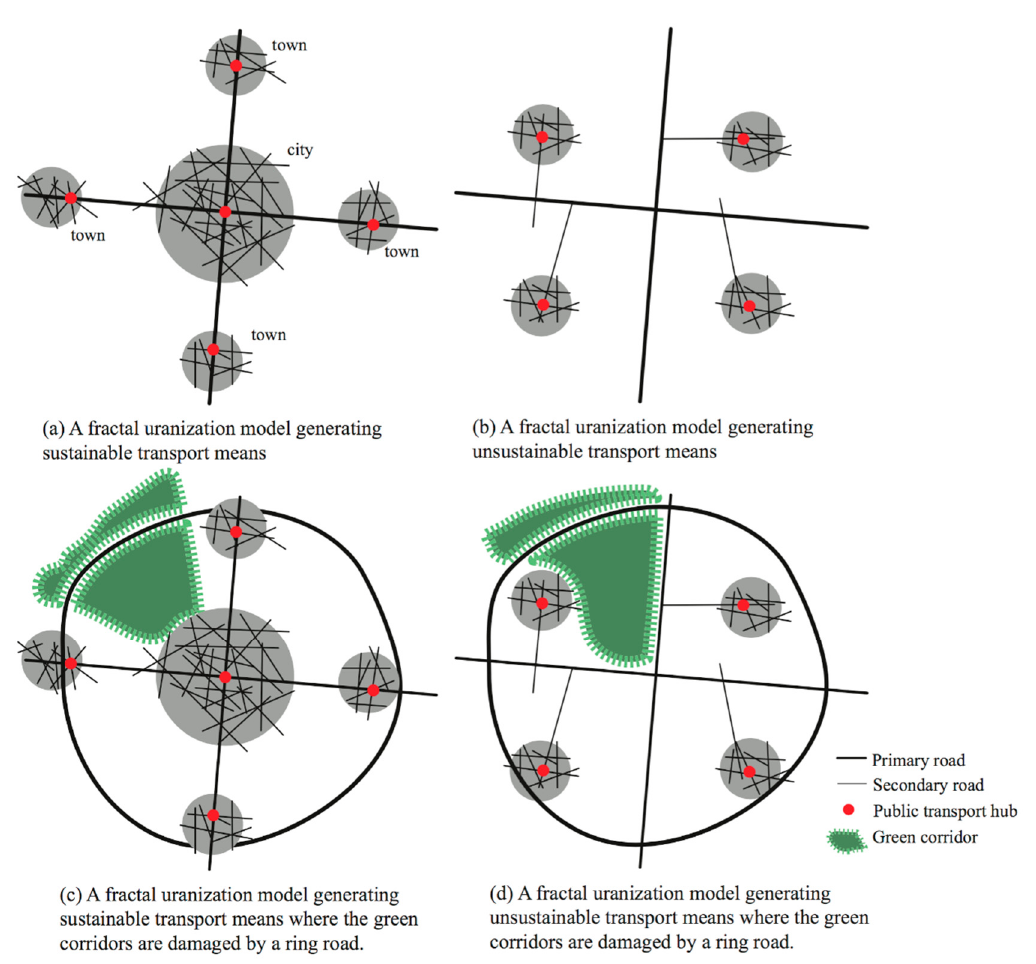
Figure 8. Schemes showing some spatial fractural principles in the relationship between the local street network in neighborhoods or villages and the larger metropolis. The image, top left, is reminiscent of the logic used in our multifractal planning logic for designing a strategic development plan and development scenario for creating sustainable means of mobility.